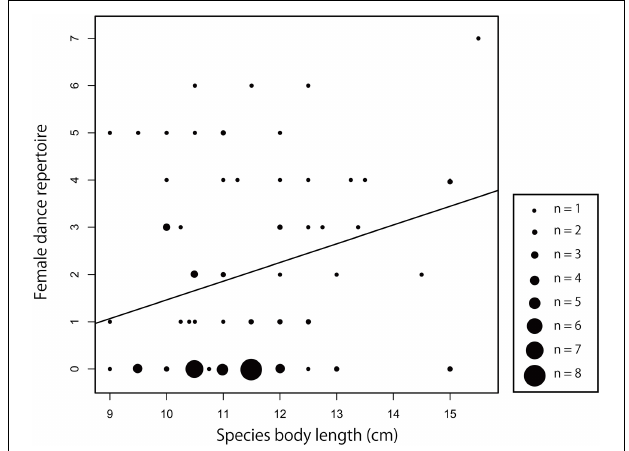
FIGURE 5 | Interspecific association between body size and dance complexity of females. Dots are species-specific estimates, line is the PGLS regression line that is estimated in the corresponding phylogenetic model ( Table 2 ).